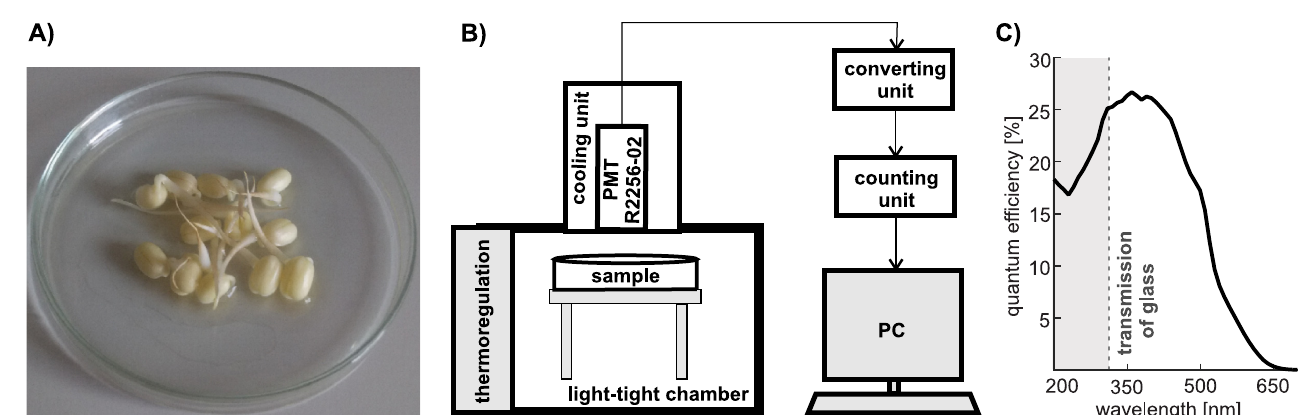
Fig 1. A: Sample of germinating mung beans. B: Scheme of the luminescence measurement setup. C: Quantum efficiency of the photomultiplier used for the detection of biological autoluminescence.